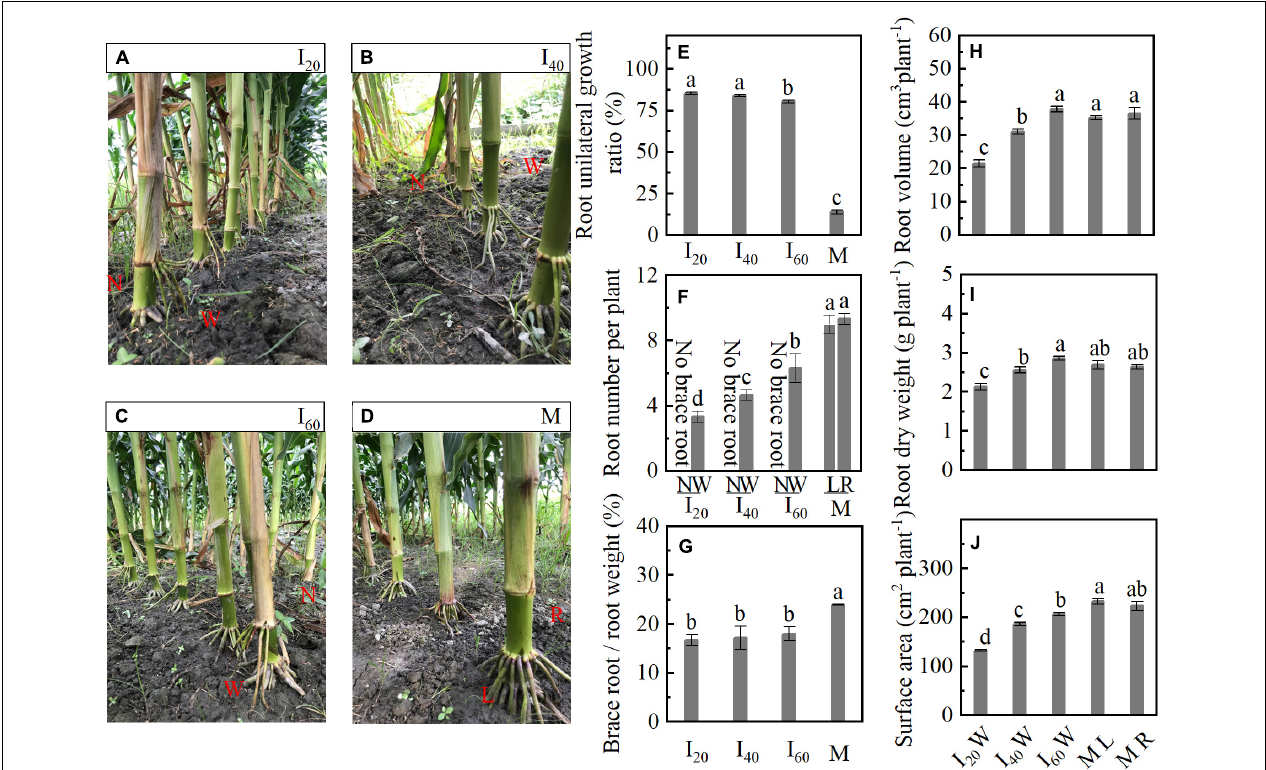
FIGURE 3 | Unilateral root growth ratio and morphology in Study 1 (2020). I 20 , I 40 , and I 60 represent the intercropping maize planted in narrow–wide row spacing patterns, narrow and wide row spacing of 20 + 200, 40 + 180, and 60 + 160 cm, respectively. M: monoculture maize with a row spacing of 70 cm. ML: the left side of monoculture plant; MR: the right side of monoculture plant. (A–D) The narrow row (N) and wide row (W) brace root of I 20 , I 40 , I 60 , and monoculture brace root character, respectively. (E) Brace root unilateral growth ratio; (F) the number of narrow-row and wide-row brace root; (G) the ratio between the brace and total root (including primary root, brace roots, and lateral roots). Panels (H–J) represent volume, dry weight, and surface area of brace root in wide row per plant, respectively, narrow-row no brace root, only show data for wide-row brace root. At 25 days after flowering. Data with different letters are significantly different ( p <